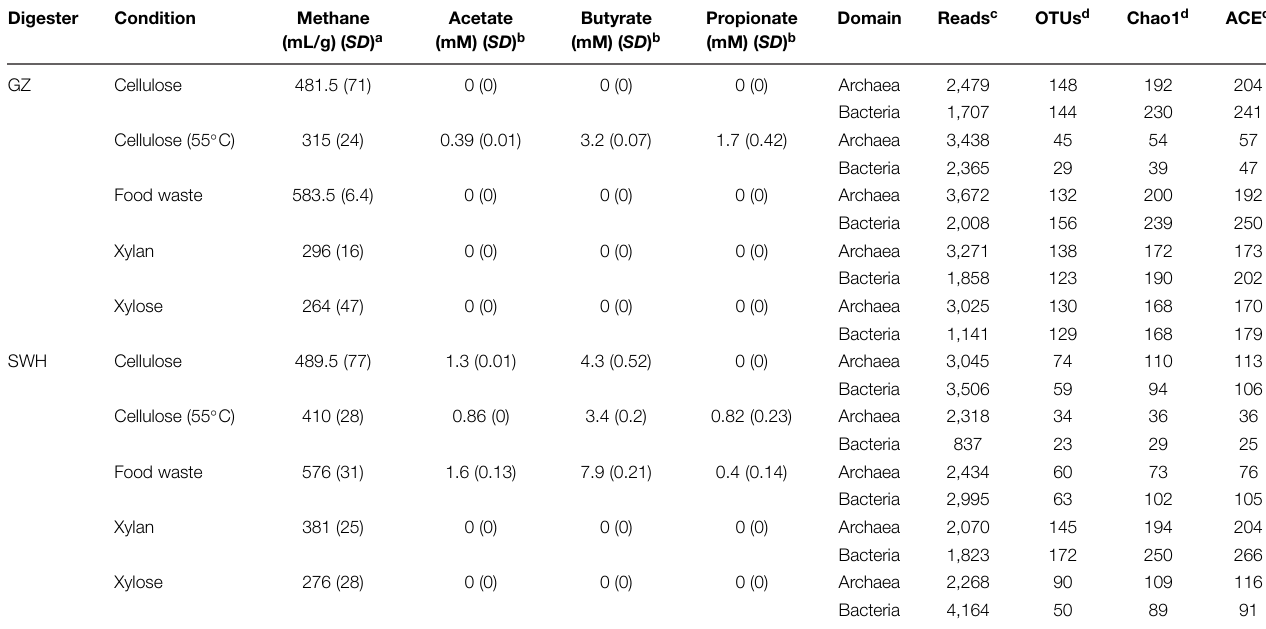
TABLE 1 | List of cultures prepared for this study, methane and volatile fatty acid (VFA) production, and details on OTU formation and alpha diversity.